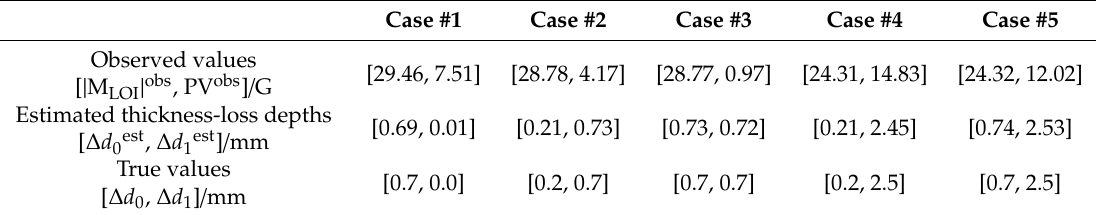
Figure 10. The established databases via the forward model: ( a ) the calibration curve of |M LOI | = f ( ∆ d 1 ); ( b ) the database of peak value (PV) = f ( ∆ d 0 , ∆ d 1 ). Table 3. Comparison of ∆ d 0est and ∆ d 1est with the true